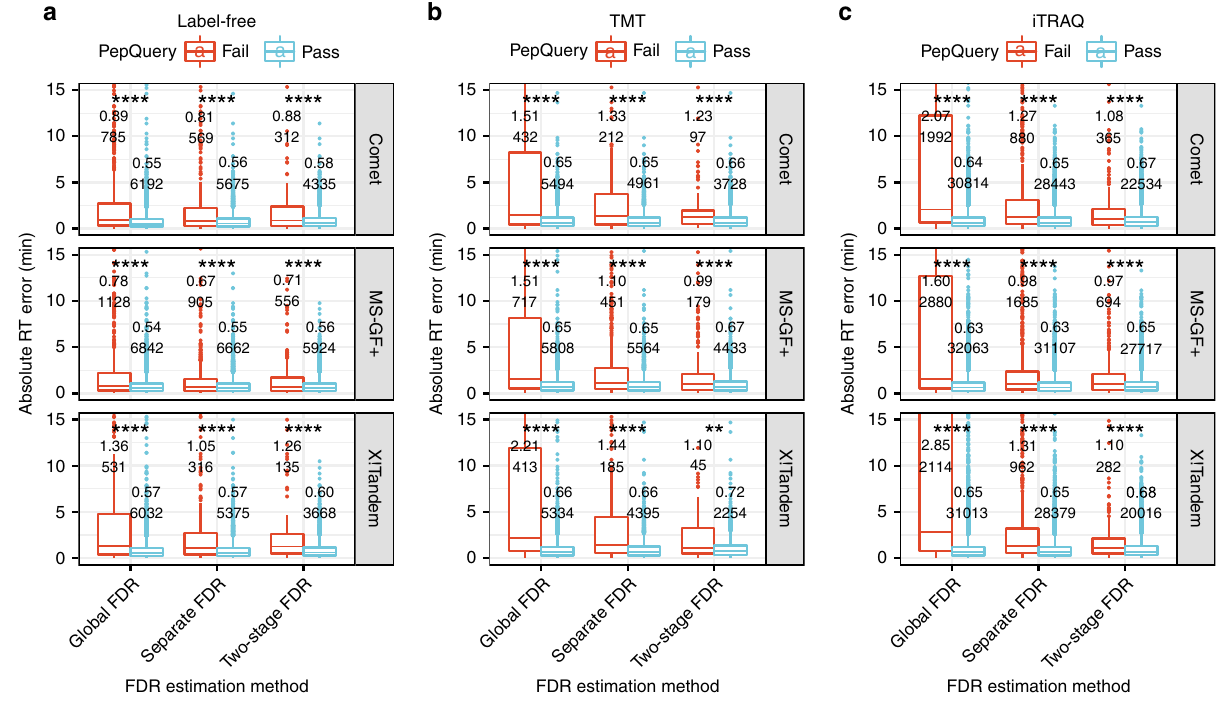
Fig. 4 Variant peptide identi fi cation quality evaluation. Absolute retention time (RT) error distributions for variant peptide identi fi cations in the label-free data set a , the TMT data set b and the iTRAQ data set c . Numbers in the fi rst rows of the boxplots are the median absolute RT error values. Numbers in the second rows are the number of identi fi ed variant peptides summed across all samples in each group. ns: p > 0.05; *: p ≤ 0.05; **: p ≤ 0.01; ***: p ≤ 0.001; ****: p ≤ 0.0001 (Wilcoxon rank sum test). Source data are provided as a Source Data fi le. For boxplots, centerline indicates the median, box limits indicate upper and lower quartiles, whiskers indicate the 1.5 interquartile range and points indicate outliers. The Y axis was limited to up to